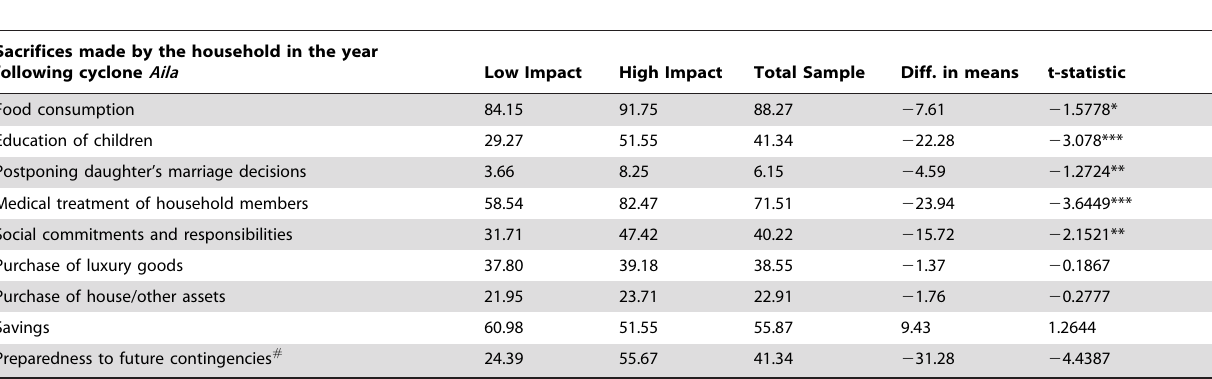
Table 4. Proportion of households incurring sacrifices of different items according to self-assessed intensity of climatic shock, Sundarbans, West Bengal,